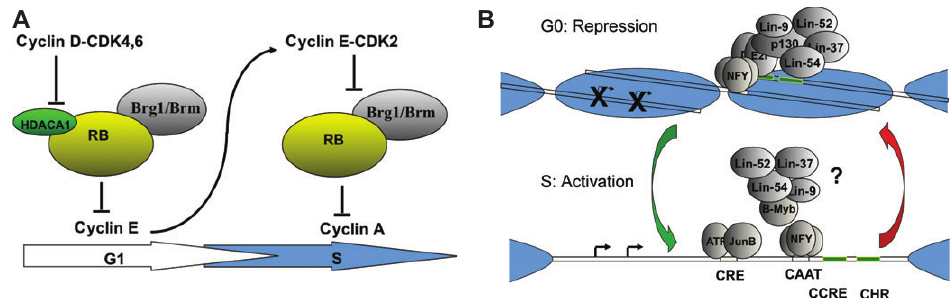
Figure 1 Transcriptional regulation of cyclin A2 . (A) HDAC-pRb and SWI/SNF-pRb maintain the order of cyclins E and A expression. (B) Transition from a repressed to an active cyclin A2 transcriptional state results from both chromatin remodeling and a switch in the composition of bound transcription